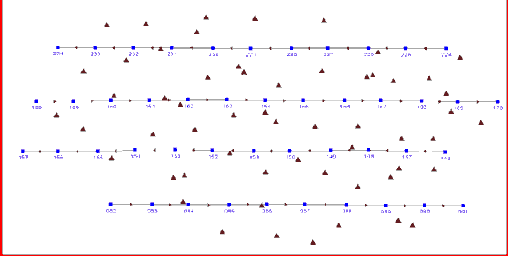
Figure 5. Photo-control points distribution of area 2